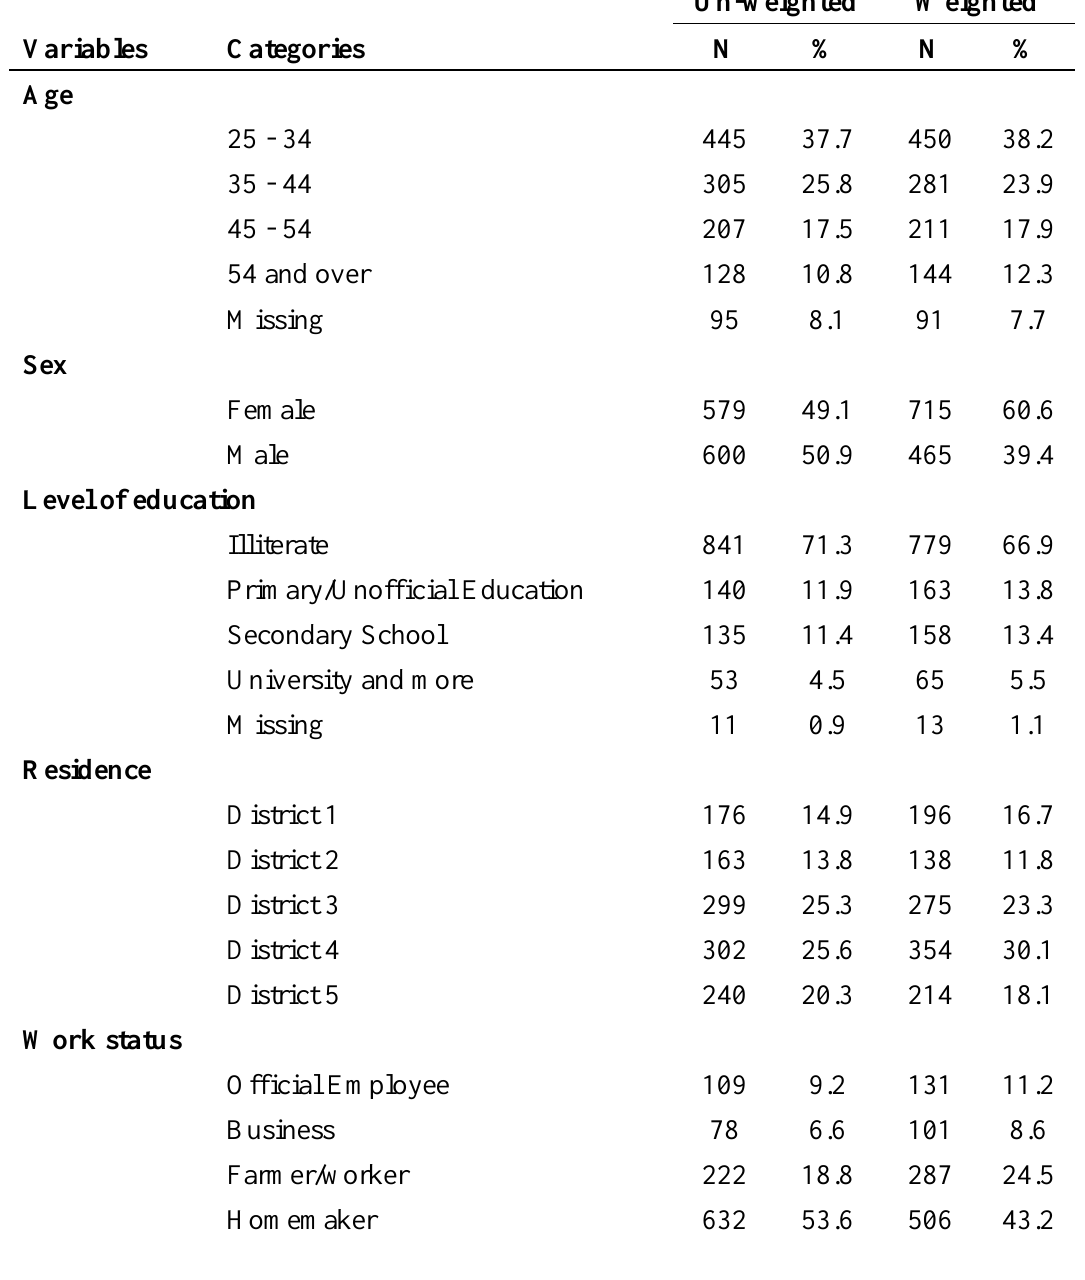
Table 1: Participant characteristics among those surveyed using the WHO STEPS in Jalalabad, Nangarhar,